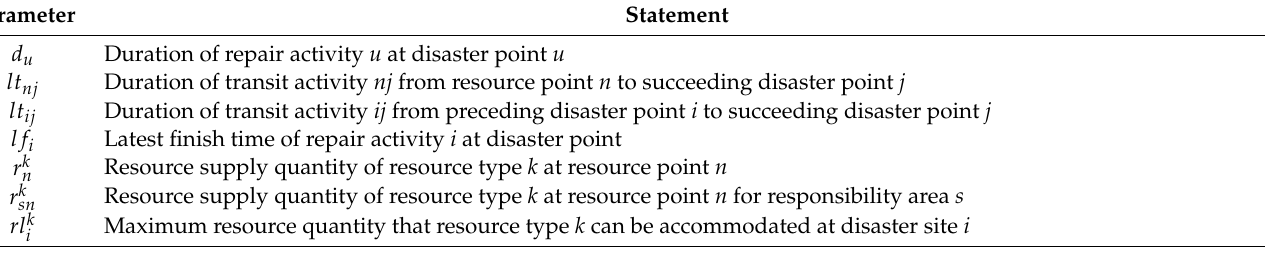
Table 1. Parameters and variables of the proposed